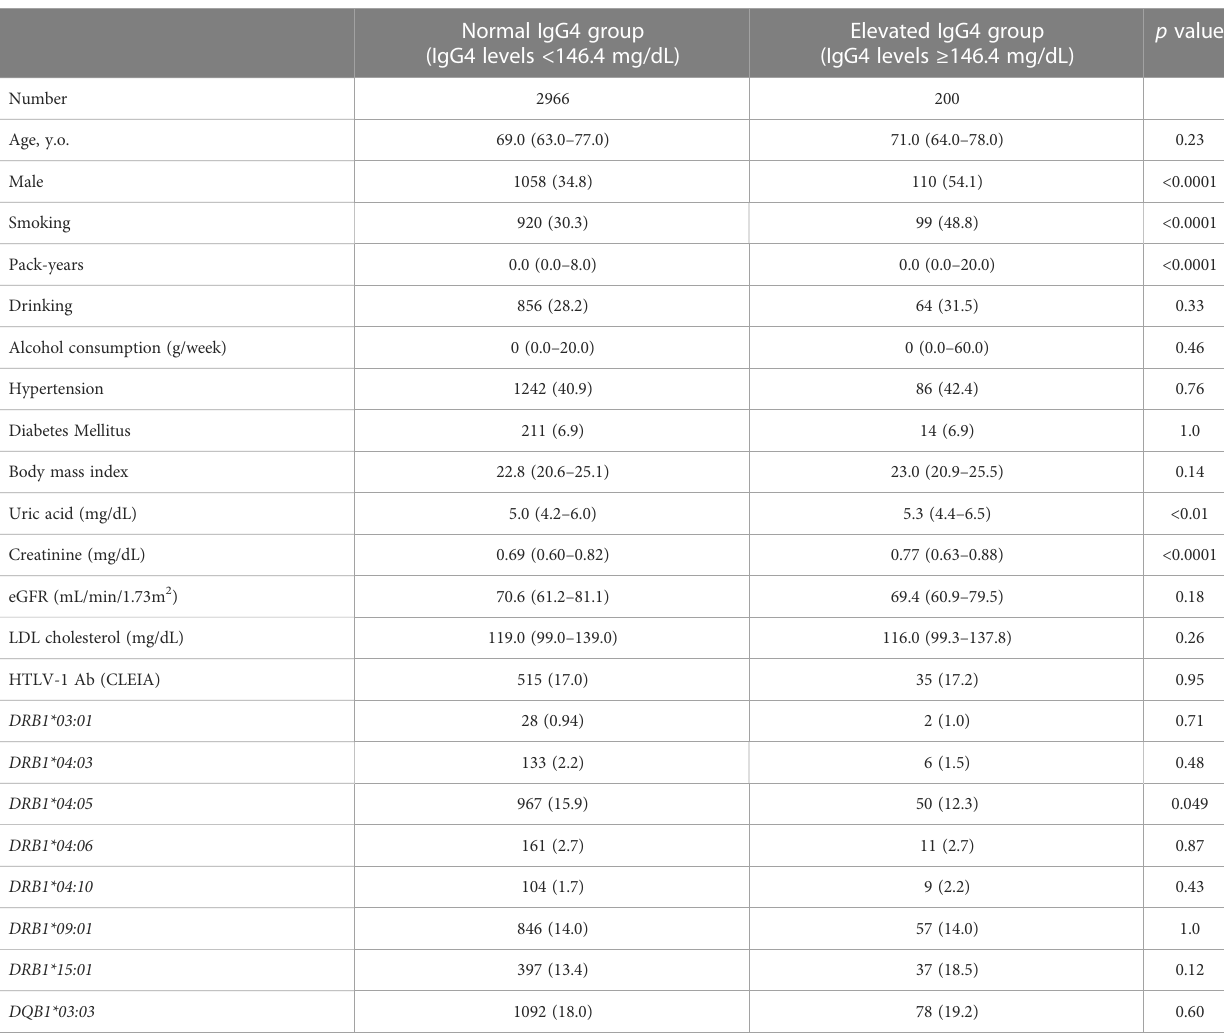
TABLE 1 Univariate analysis strati fi ed by serum IgG4 level in NaIS.